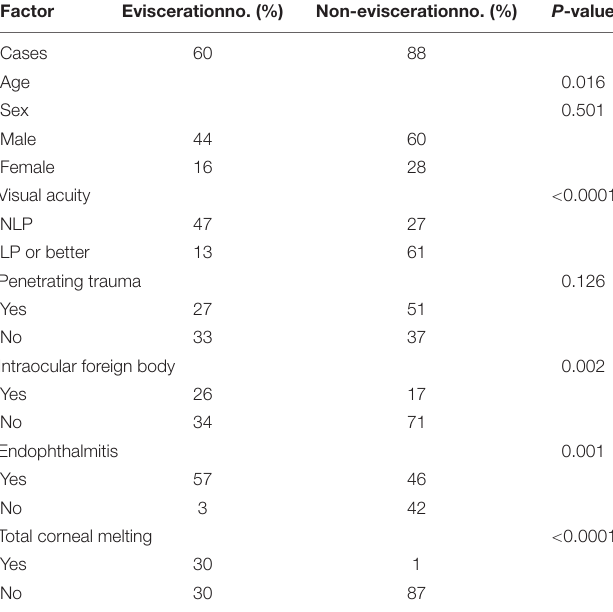
TABLE 2 | Multivariate analysis of the independent risk factors for NLP.